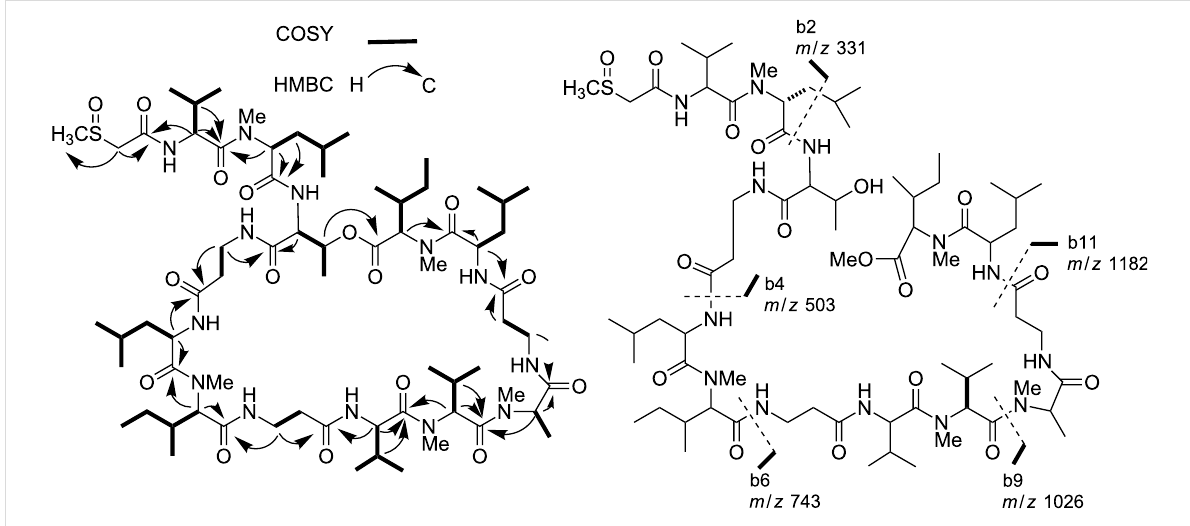
Figure 3: COSY and key HMBC correlations (left) and MS/MS fragmentations of 2 and its ring-opened methanolysis product, respectively.